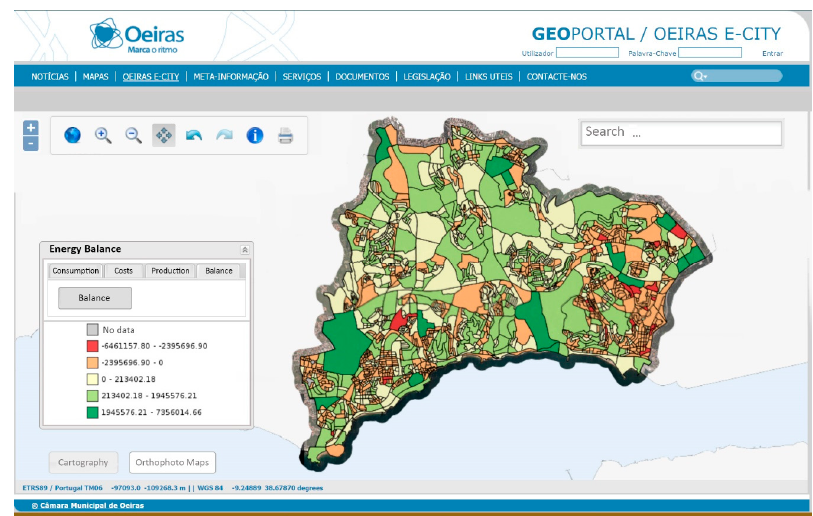
Figure 10. Energy Balance page of the E-City web platform.